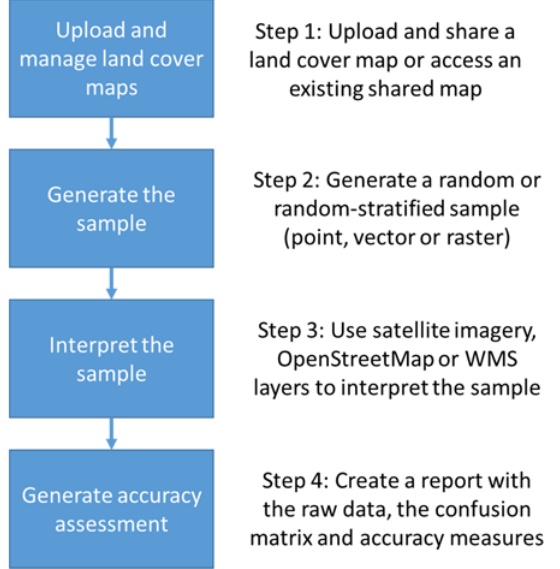
Figure 2. The components of the LACO-Wiki workflow.